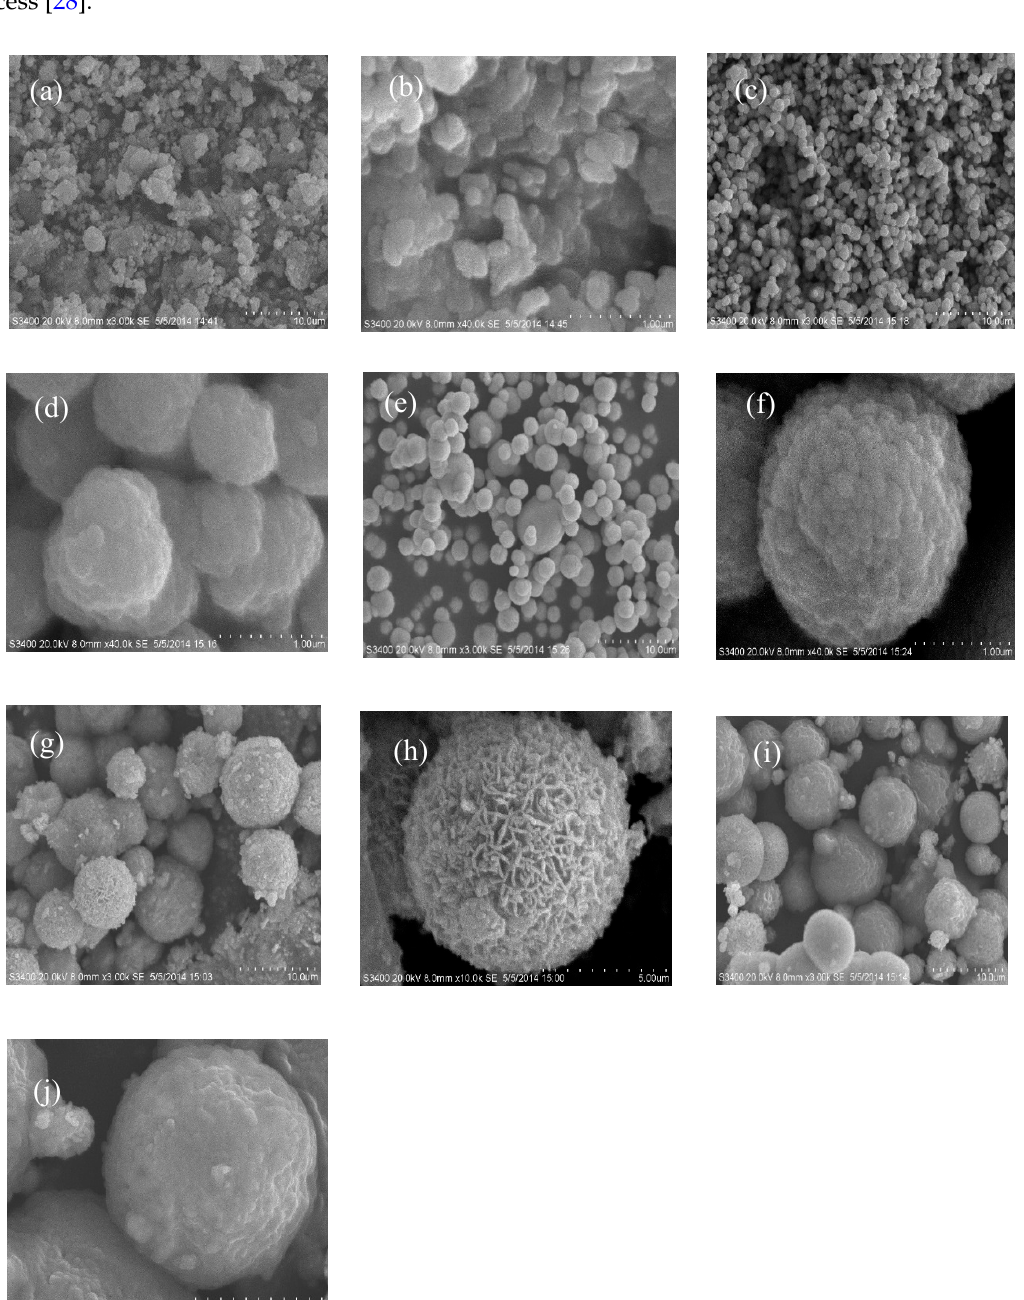
Figure 2. Scanning electron microscopy ( SEM) images of ( a , b ) BiOI; ( c , d ) BiOCl; ( e , f ) BiOBr; ( g , h ) BiOI/BiOCl and ( i , j ) BiOI/BiOBr with different magnification levels.